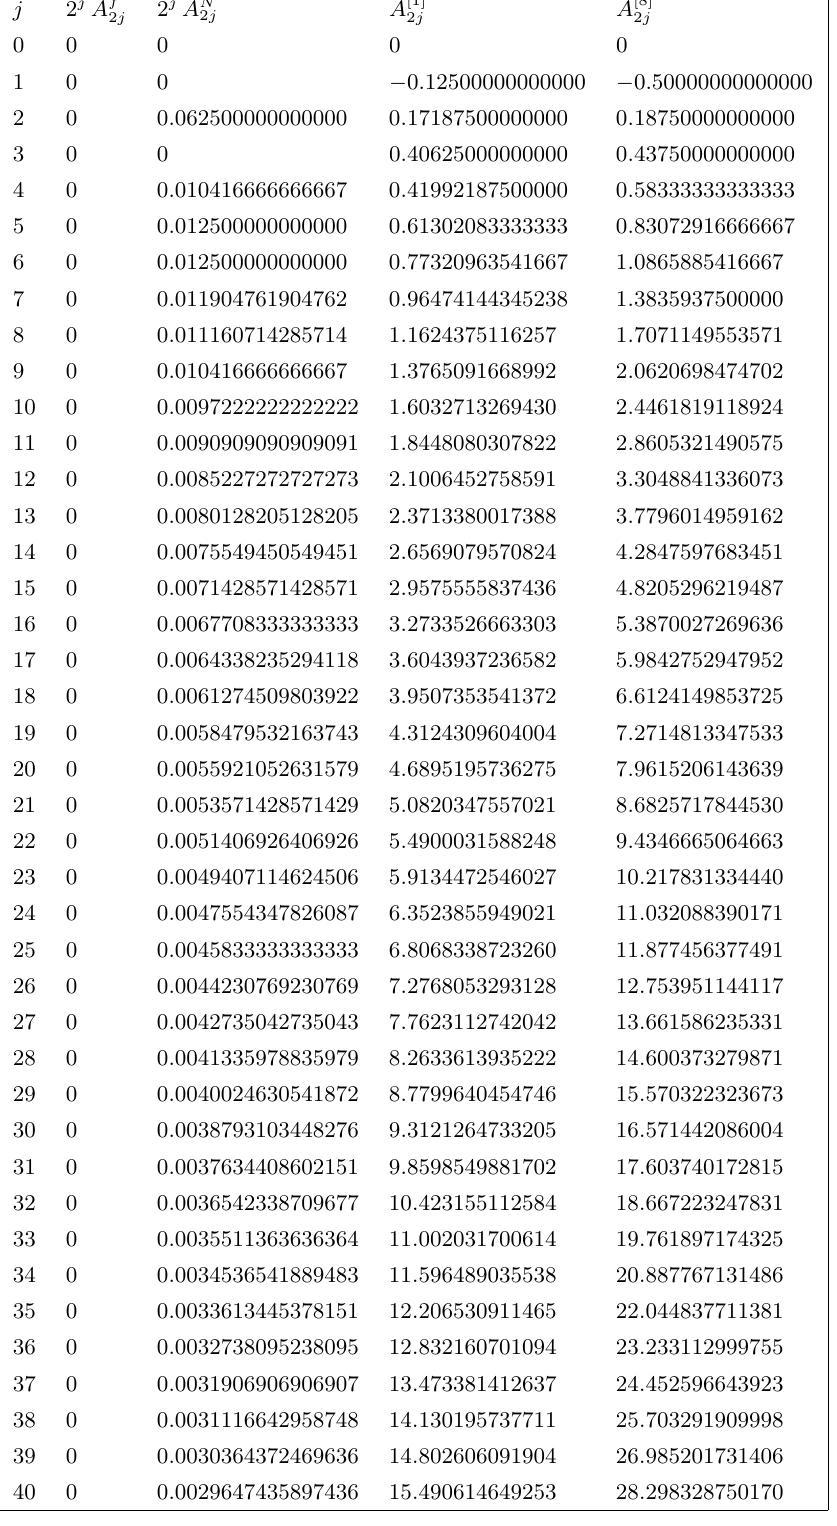
Table 3 . Coe(cid:14)cients of the term including ln 2 ( z ) in the asymptotic expansion at z =